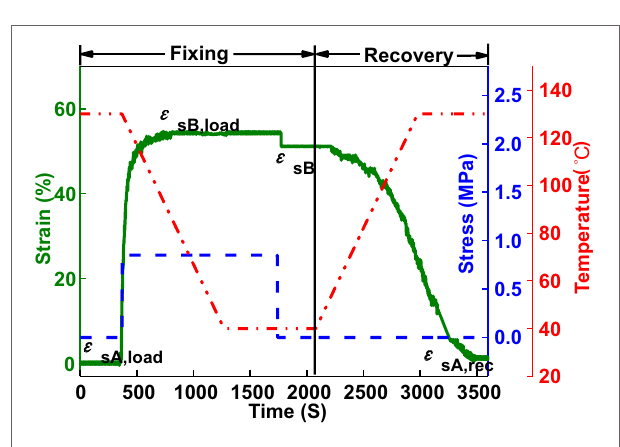
FiGURe 4 | Shape memory cycle test. (With kind permission from Springer Science+Business Media: Zhang et al.,